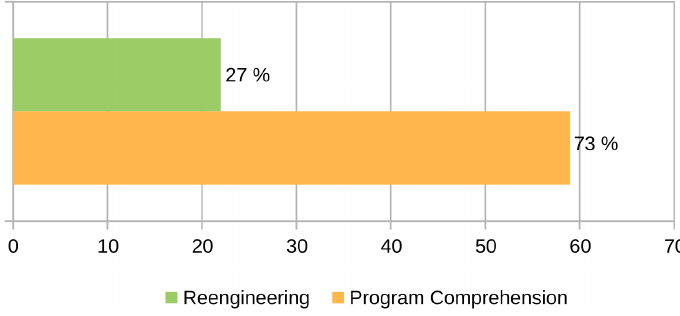
Figure 12. Types of maintenance techniques used in the